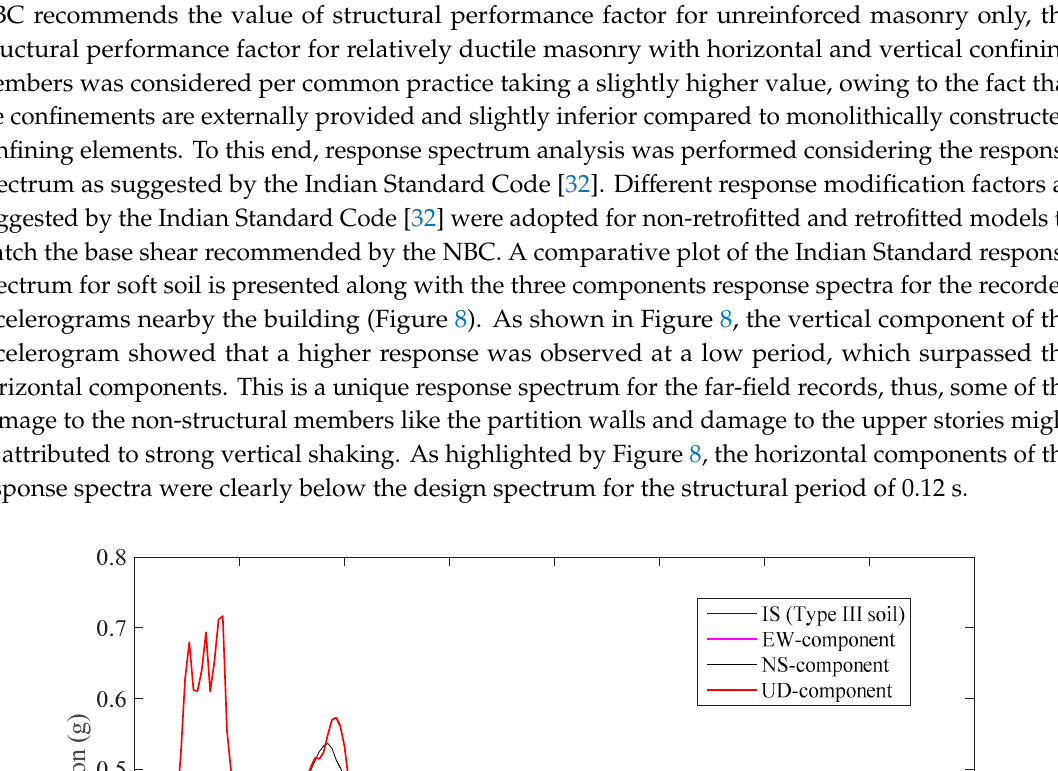
Figure 7. Three ‐ dimensional finite element model of Bagh Durbar.